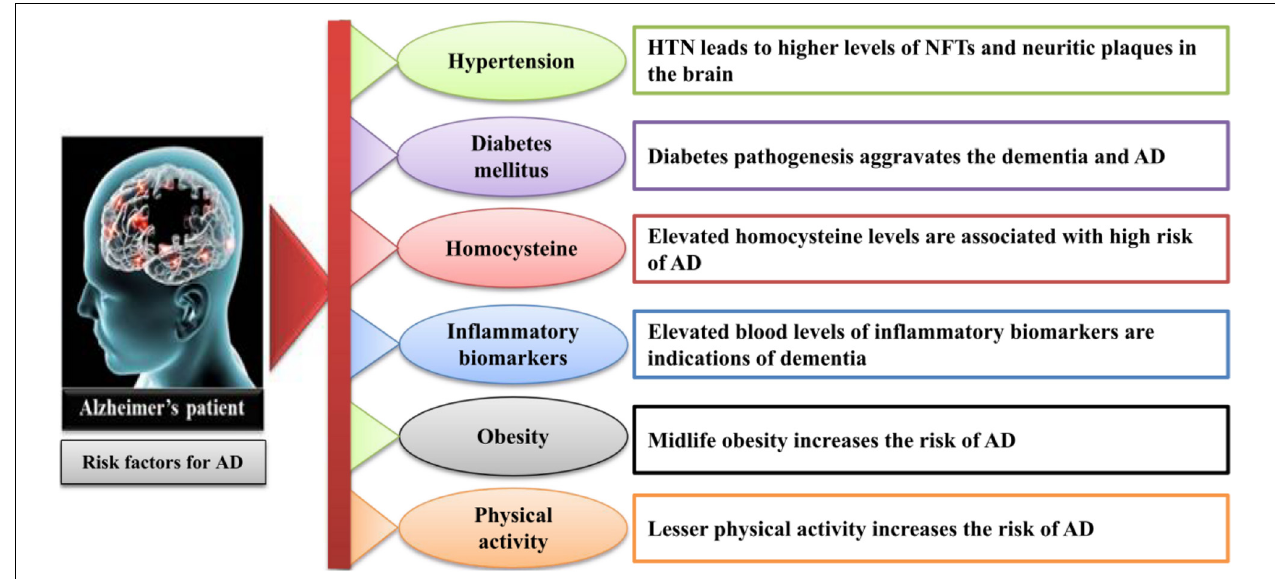
FIGURE 1 | The lifestyle- and age-related factors involved in the onset of AD. AD, Alzheimer’s disease; HTN, hypertension; NFT, neurofibrillary